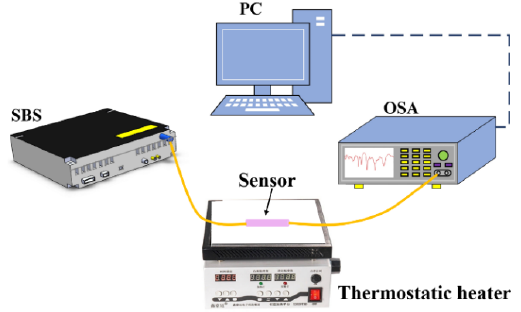
Figure 7. The experimental setup for temperature measurement.